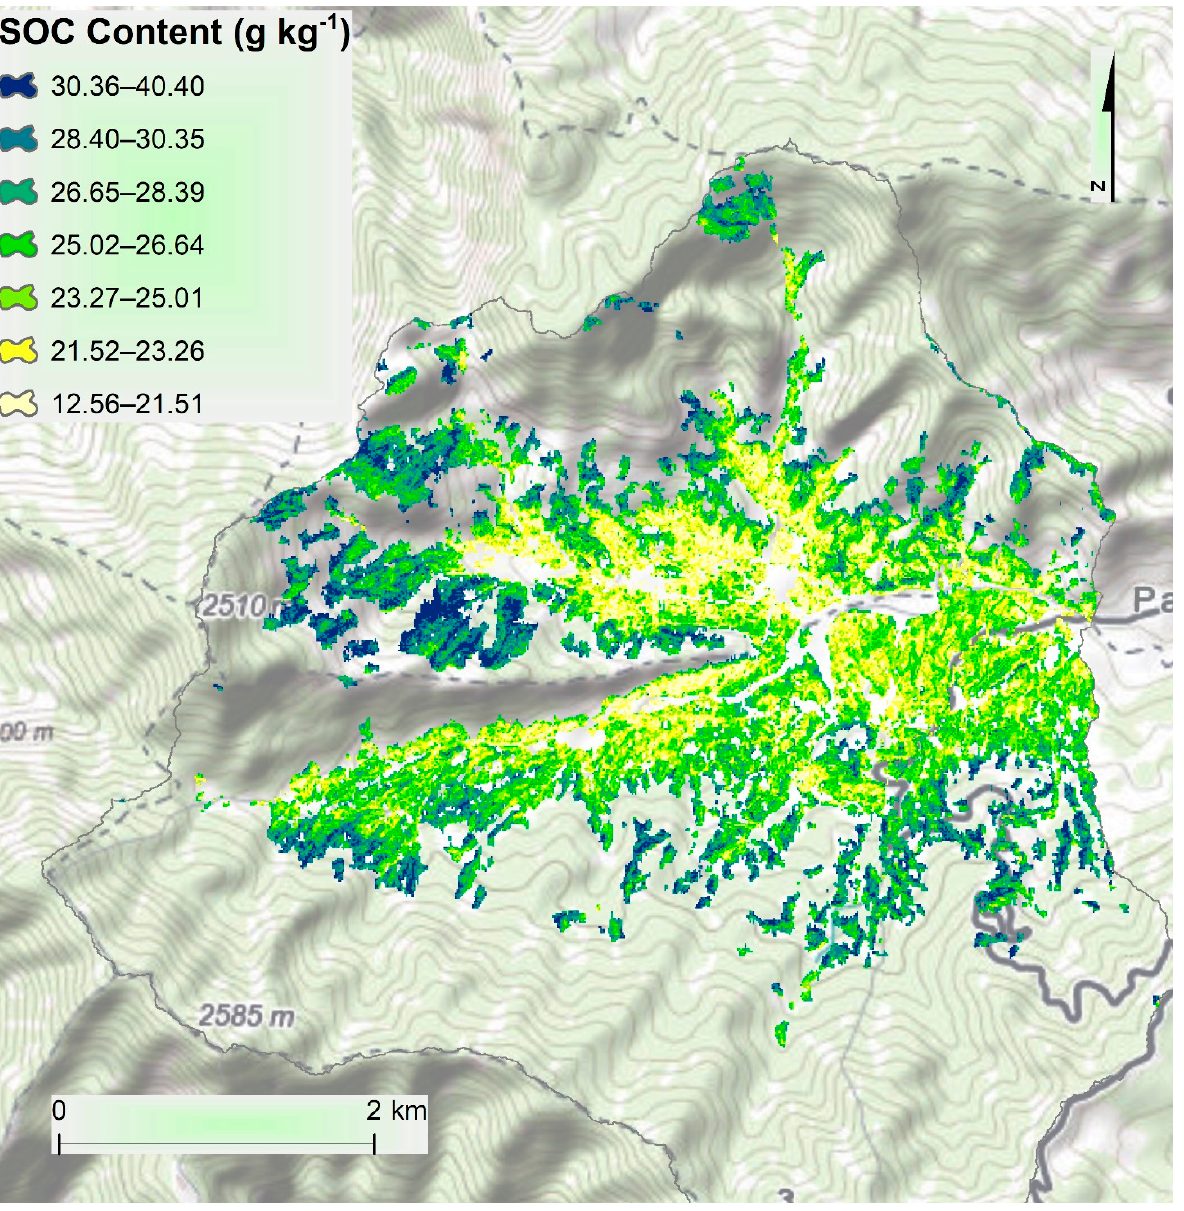
Figure 5. Predicted topsoil organic carbon map of the catchment.